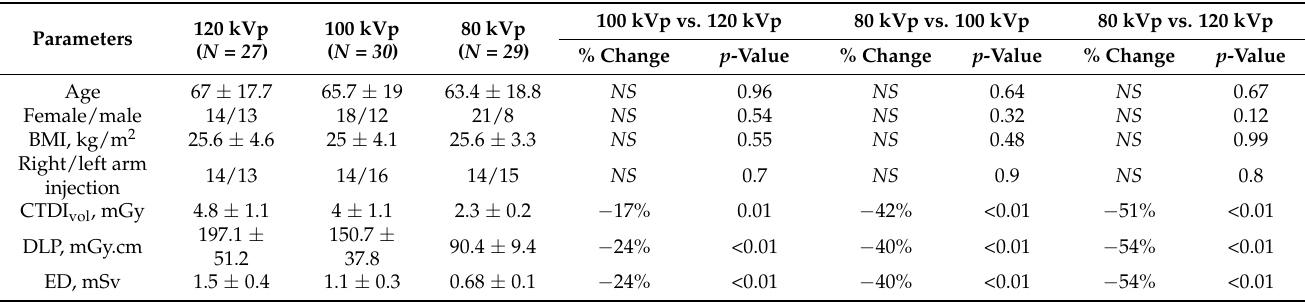
Table 3. Comparison of radiation dose to the patient with the three kVp